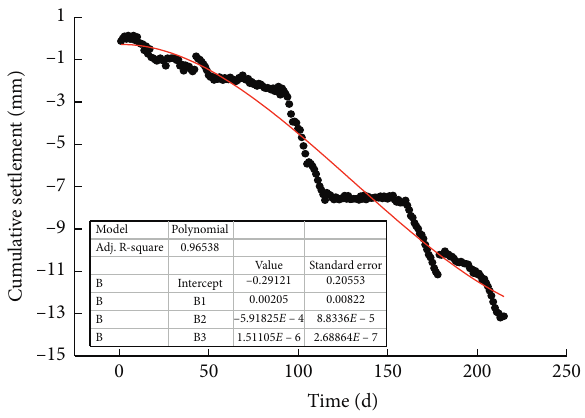
Figure 10: Data change curve fitting diagram.